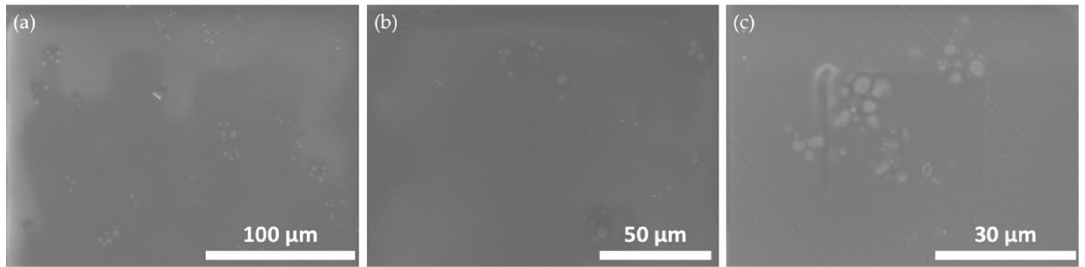
Figure 4. SEM micrographs of artificial nails after having been coated with ( a ) np1, ( b ) np2, and ( c ) np3 for 120 h.